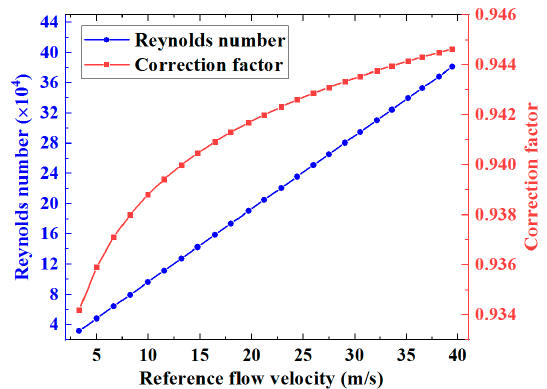
Figure 8. Reynolds number and correction factor as functions of reference flow velocity.